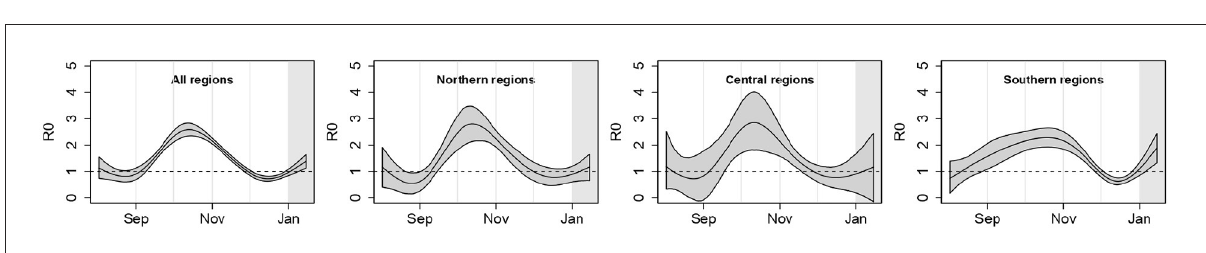
3.3% (Veneto) to 22.6% (Valle d’Aosta), those at 14 days ranged from 4.1% (Basilicata) to 26.0% (Valle d’Aosta) (see Supplementary Table